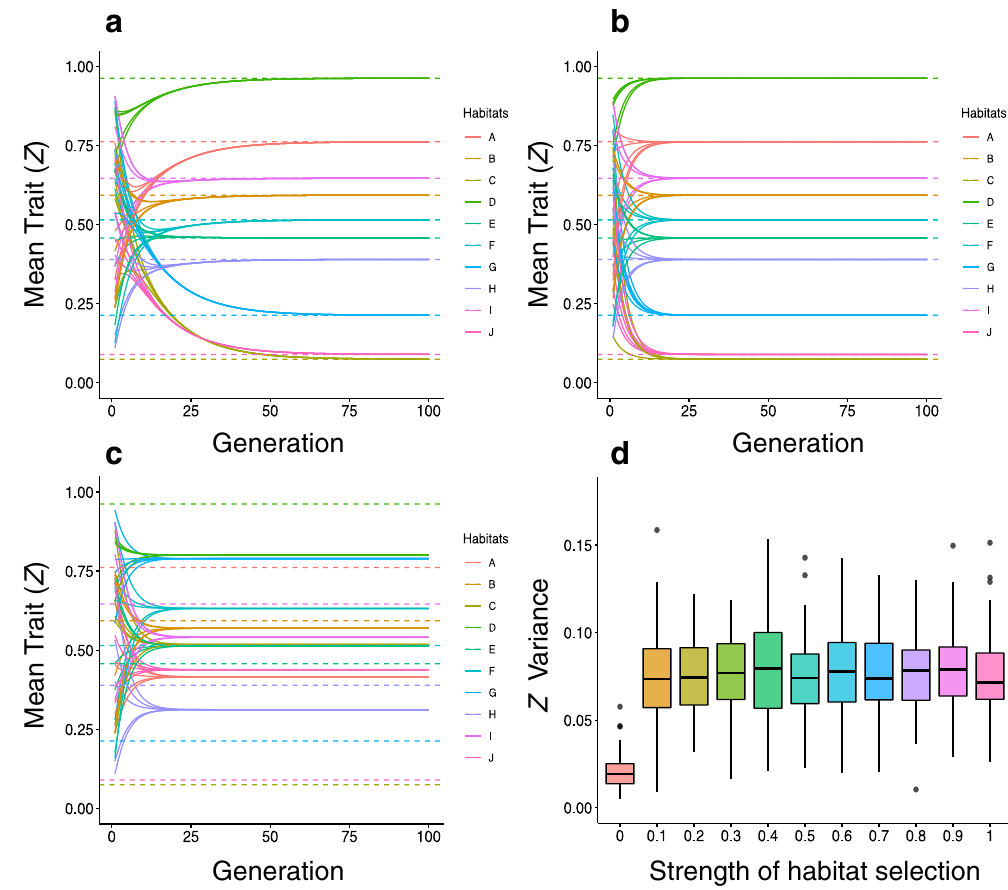
Figure 4. Exploring evolutionary change in trait mean values under mimetic and habitat-based selection. In these simulations species are loyal to their habit, occurring in only one habitat— perfectly modular scenario . In ( a-c ) each habitat is represented by a different color, the dashed line is the habitat optima, each continuous line is one species and their color are the same as the habitat optima where they occur. ( a ) The change in trait value in 100 generations when there is both mimetic and habitat-based selection ( p = 0.3). ( b ) The change in trait value in 100 generations when there is only habitat-based selection ( p = 1 ) and no mimetic selection. ( c ) The change in trait value in 100 generations when there is only mimetic selection occurs and no habitat-based selection ( p = 0 ). (d) Variability of trait values after 100 generations in 100 simulation for different strengths of habitat